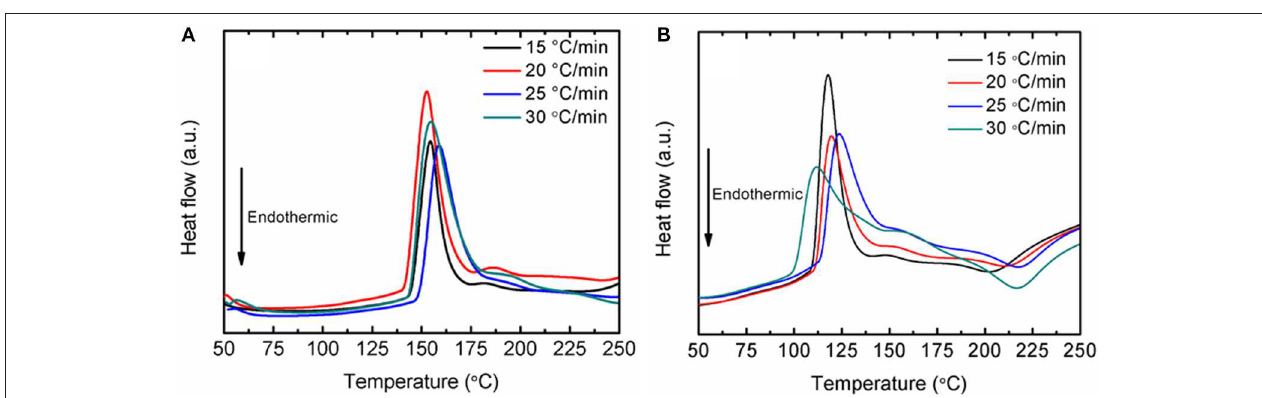
Frontiers in Chemistry |